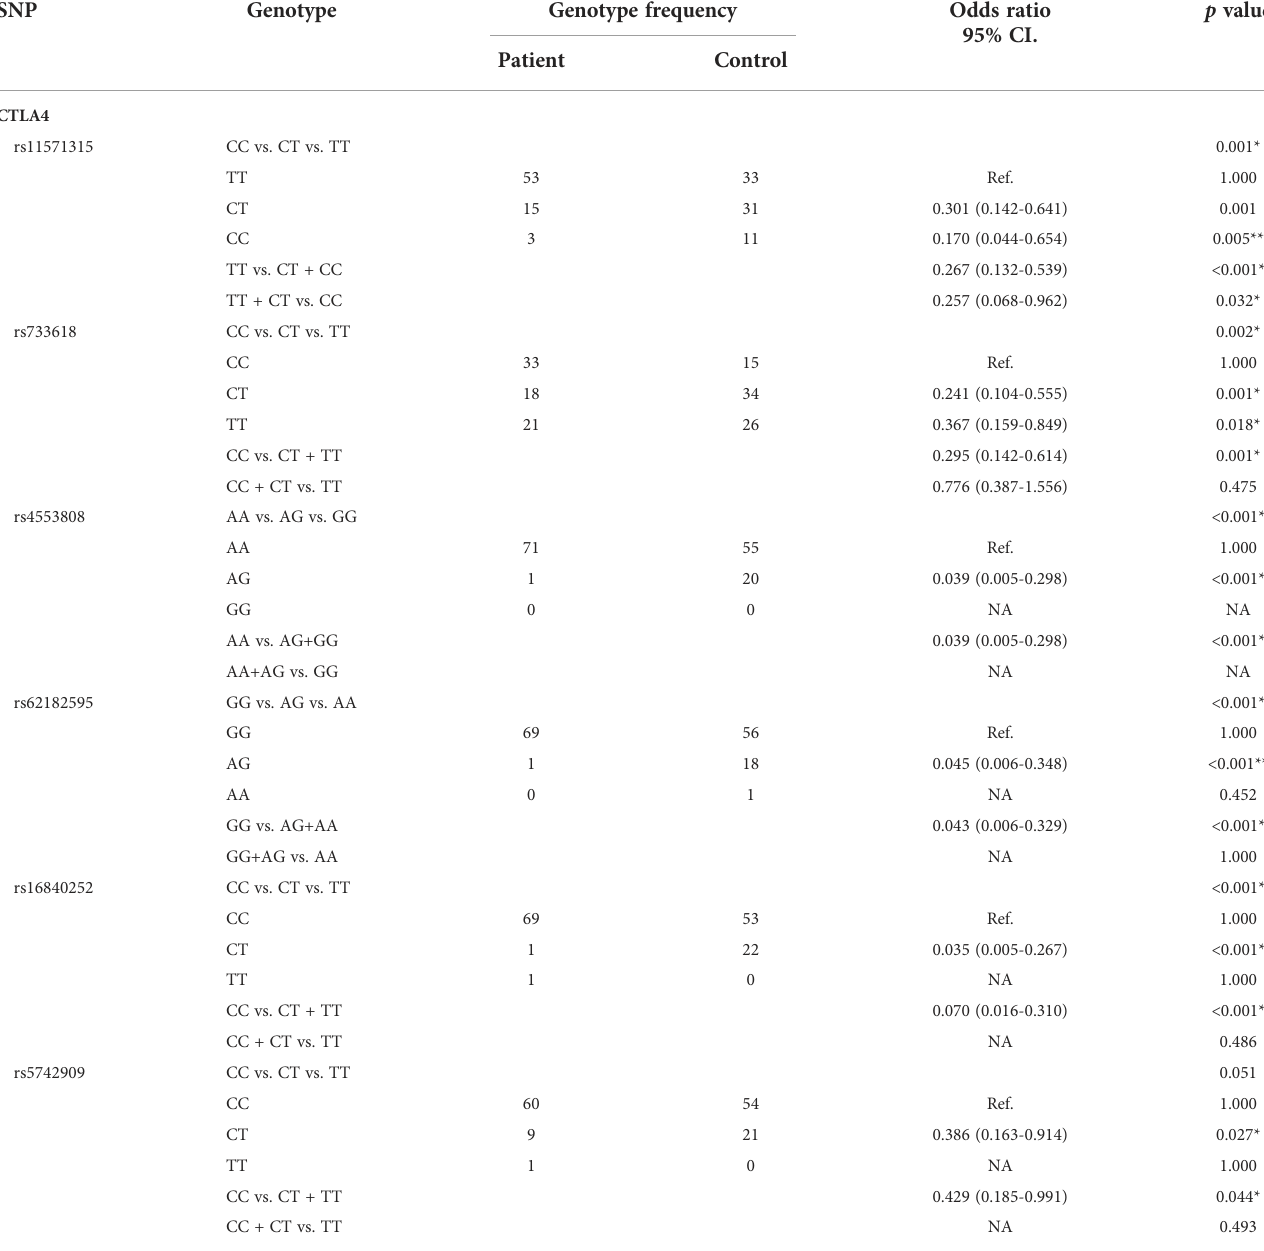
TABLE 3 Genotype frequencies of the signi fi cant SNPs in SLE cases and healthy